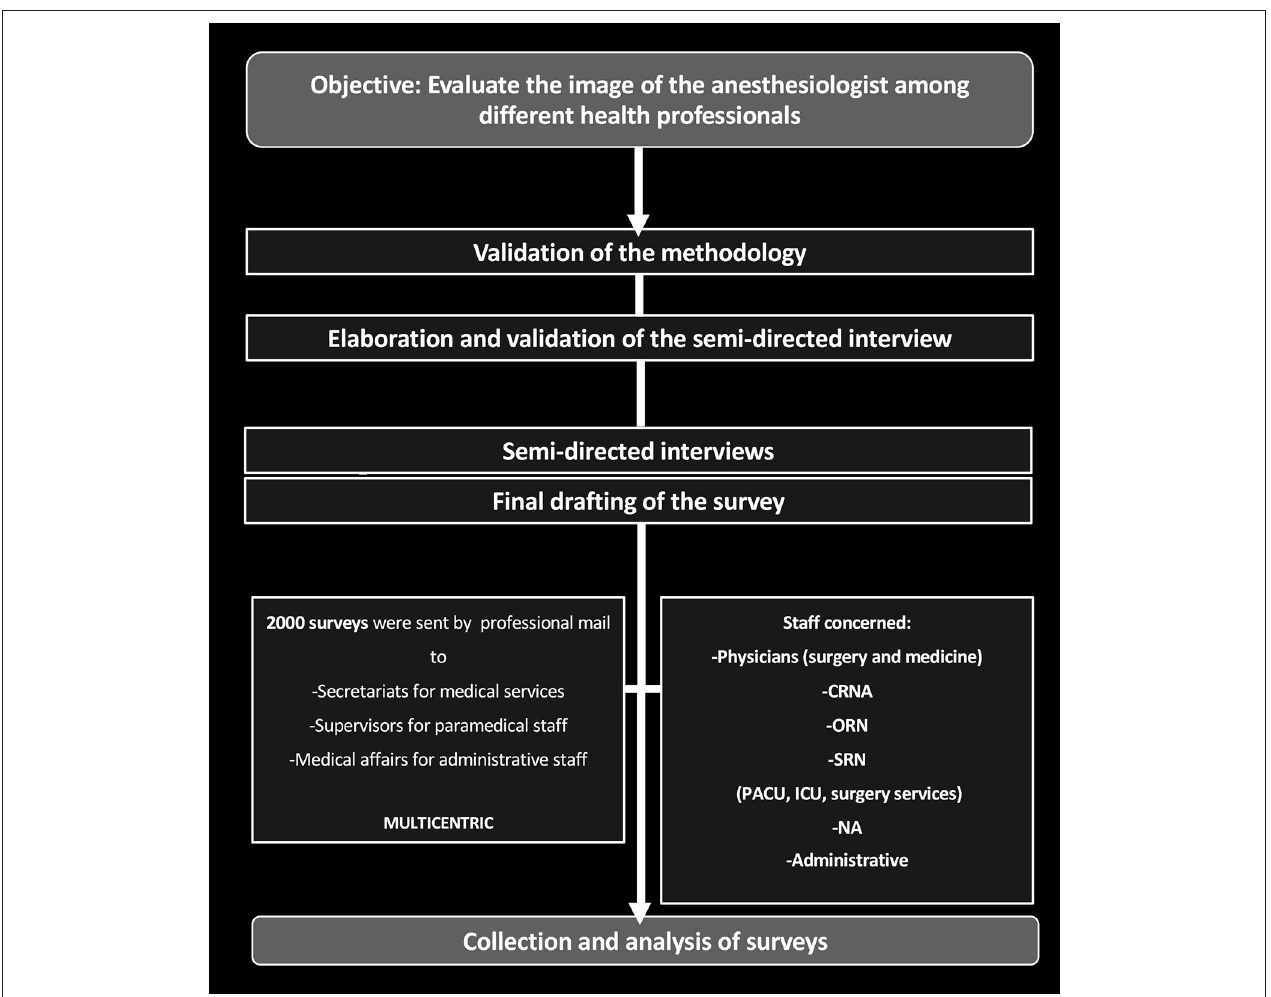
FIGURE 1 | Study design. For Likert scale, data are expressed as mean ± standard deviation (SD). CRNA, Certified Registered Nurse Anesthetist; CCU, intensive Care Unit; NA, Nursing Assistant; ORN, Operating Room Nurse; PACU, Post-Anesthesia Care Unit; SRN, State Registered